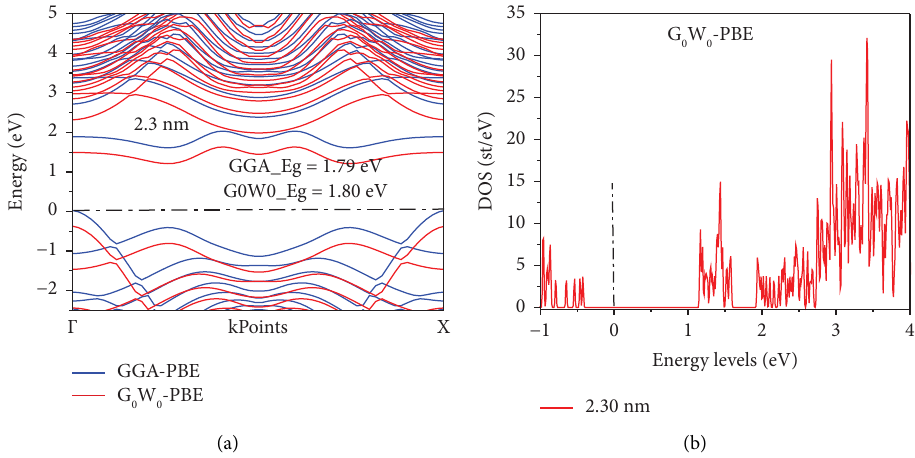
Figure 6: (a) Bands structure and (b) electronic density of states for CBNNT with 2.30nm IWD.